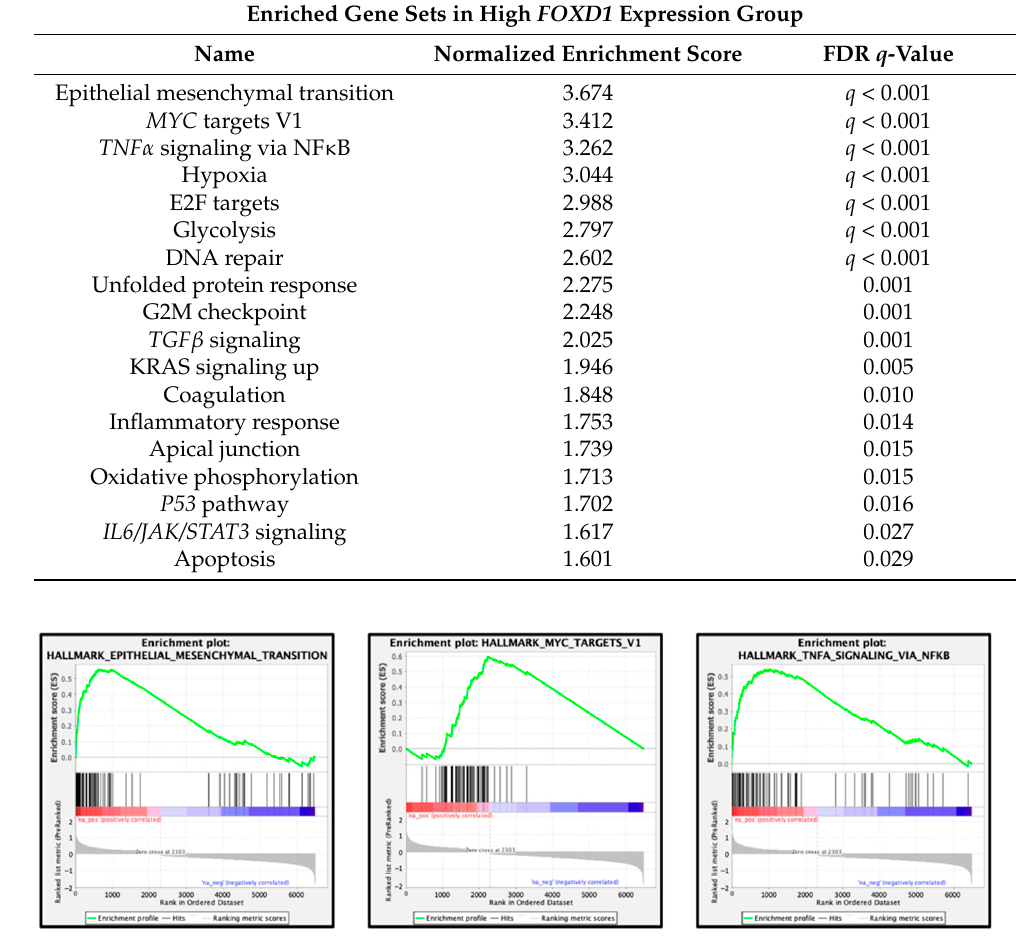
Table 3. Results of gene set enrichment analysis.